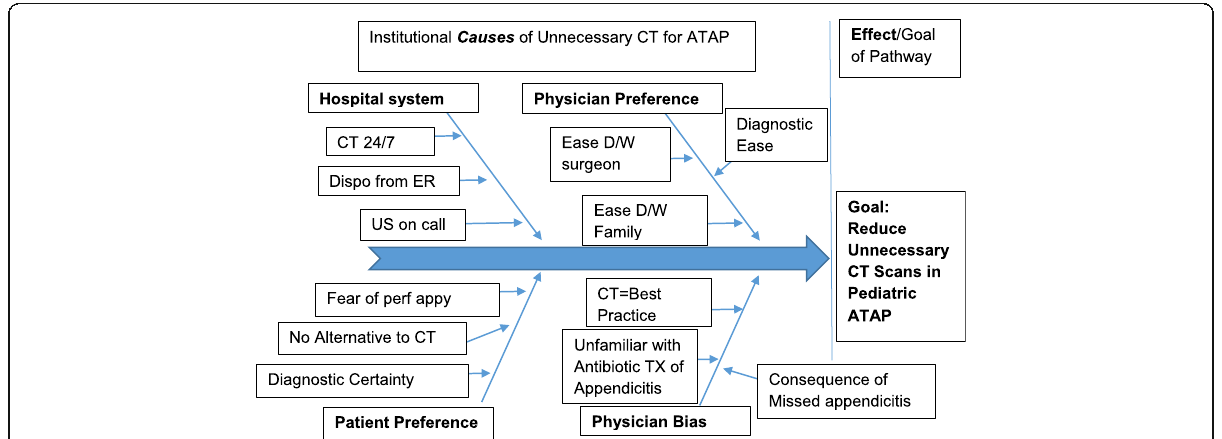
Fig. 1 Ishikawa Fishbone diagram of factors leading to excessive CT scanning in pediatric abdominal pain